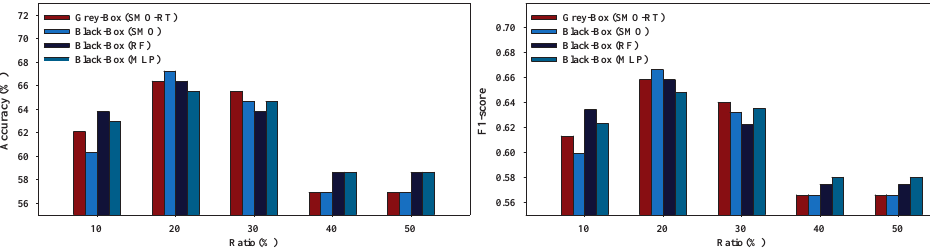
Figure 13. Box-plot with performance evaluation of Grey-Box and Black-Box models for Coimbra